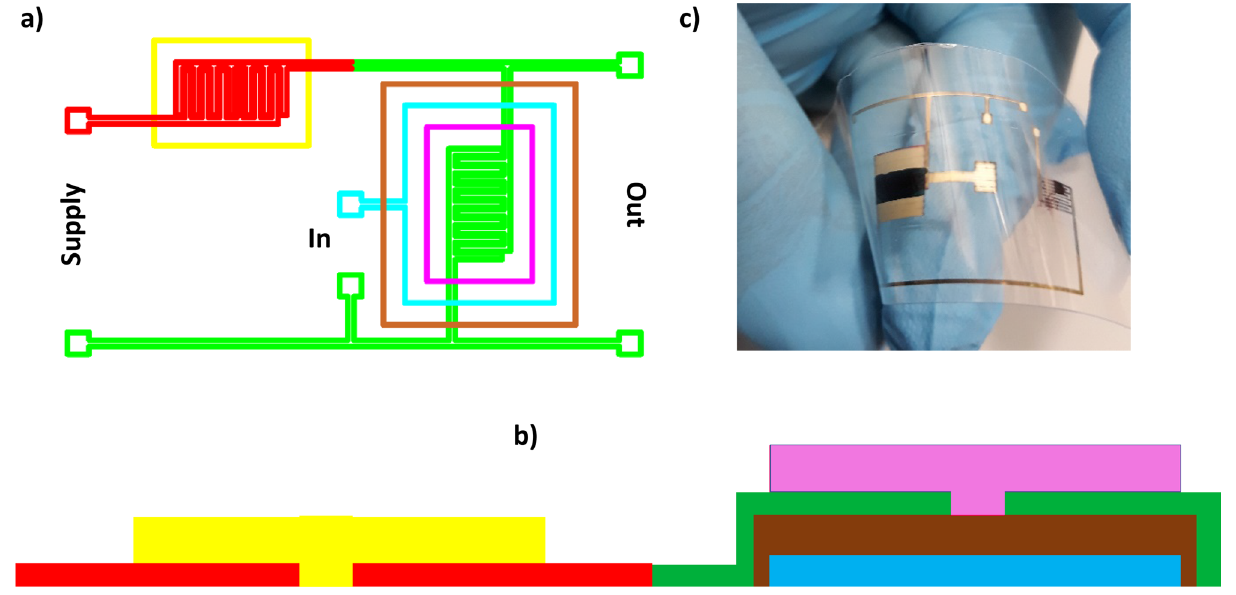
Figure 6. Schematic diagram of the NOT gate, showing successive printed layers: the gate electrode (blue rectangle area); dielectric printed on the electrode surface (brown rectangle area); source and drain electrodes printed on the dielectric with conducting paths (green color); printed resistor comb electrodes (red color): semiconductor printed as the last layers of the DPPDTT (pink rectangle area); P3HT doped with water and oxygen (yellow rectangle area) ( a , b ); Photo of the printed inverter. The resistor is located on the right-hand side and the transistor on the left-hand side of the image ( c